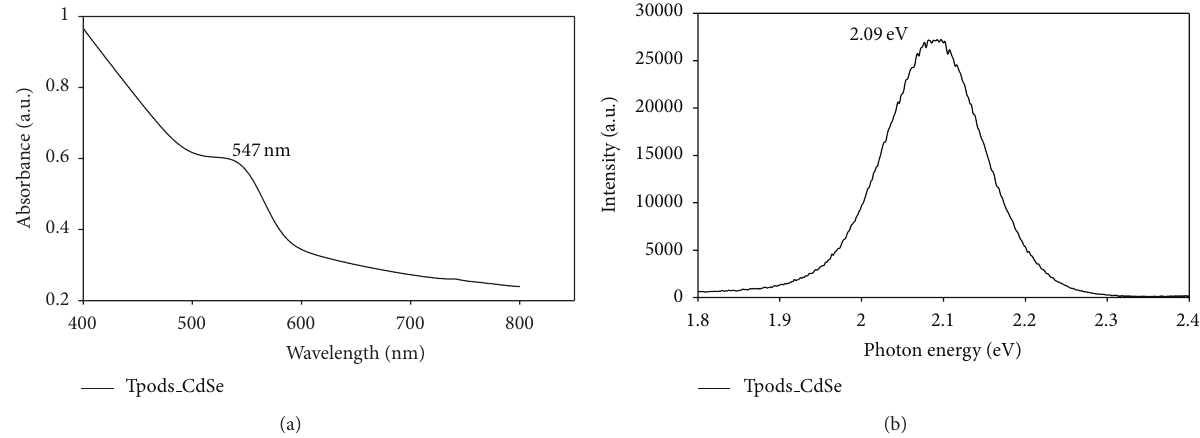
Figure 4: (a) Absorption and (b) photoluminescence spectra of the CdSe tetrapods capped with the OPA ligand.